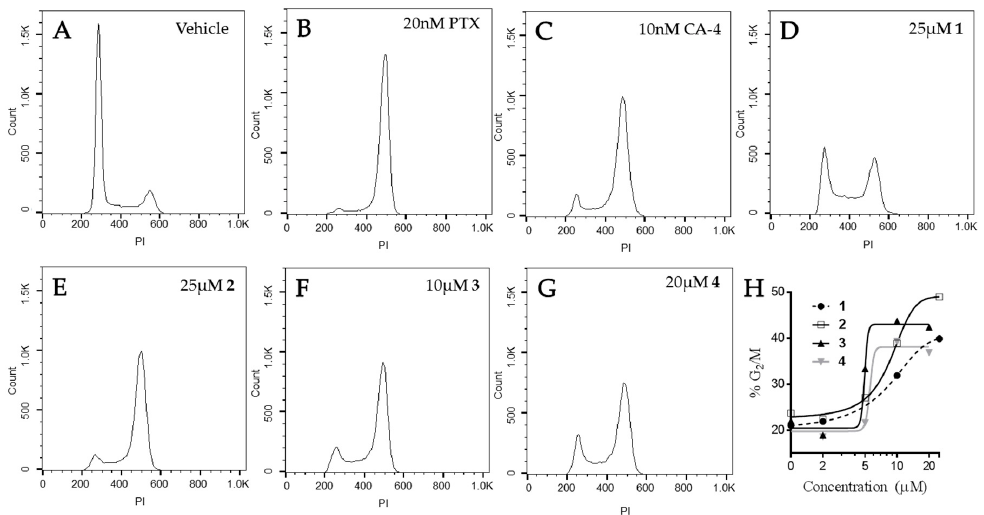
Figure 7. Effects of the Janus compounds on cell cycle distribution. HeLa cells were treated with ( A ) vehicle (DMSO), or ( B – G ) the compounds indicated for 18 h and then the DNA was stained with propidium iodide and cell cycle distribution evaluated by flow cytometry. ( H ) The concentration- dependent effects of compounds 1 – 4 on the percentage of cells in G 2 /M.